Question: What does this figure show? Answer in one sentence.
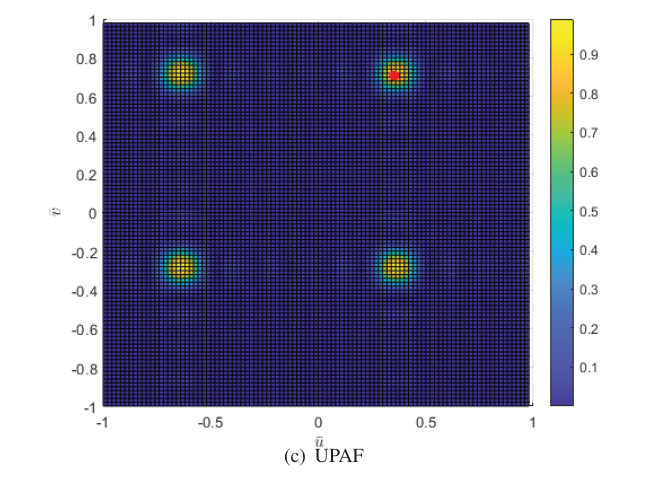
Answer: Comparison of steering vector correlation with differ- ent antennas’ positions in the case of 2D array.